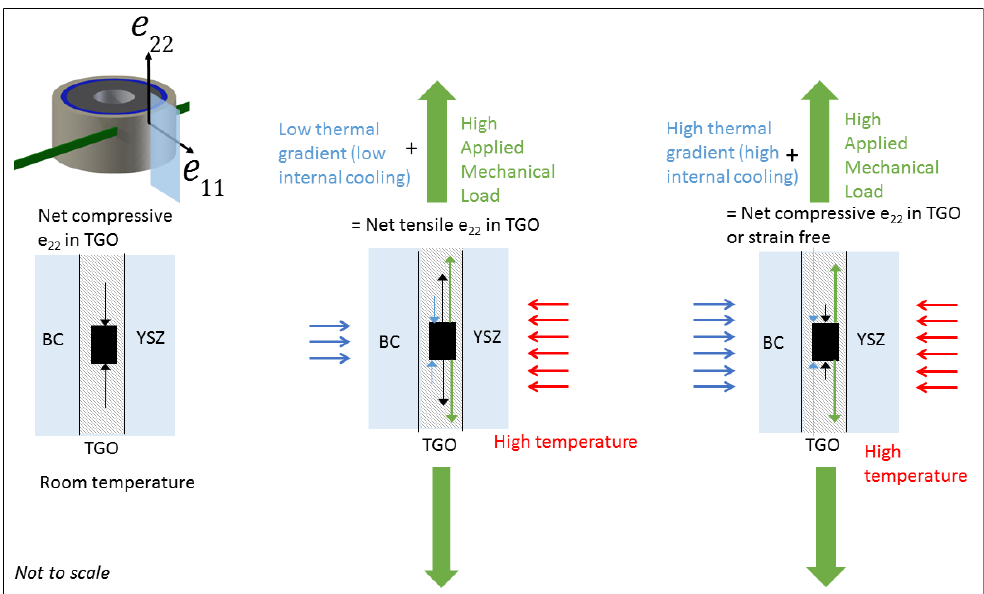
Figure 5. Schematic illustrating the competing effects of applied loads and thermal